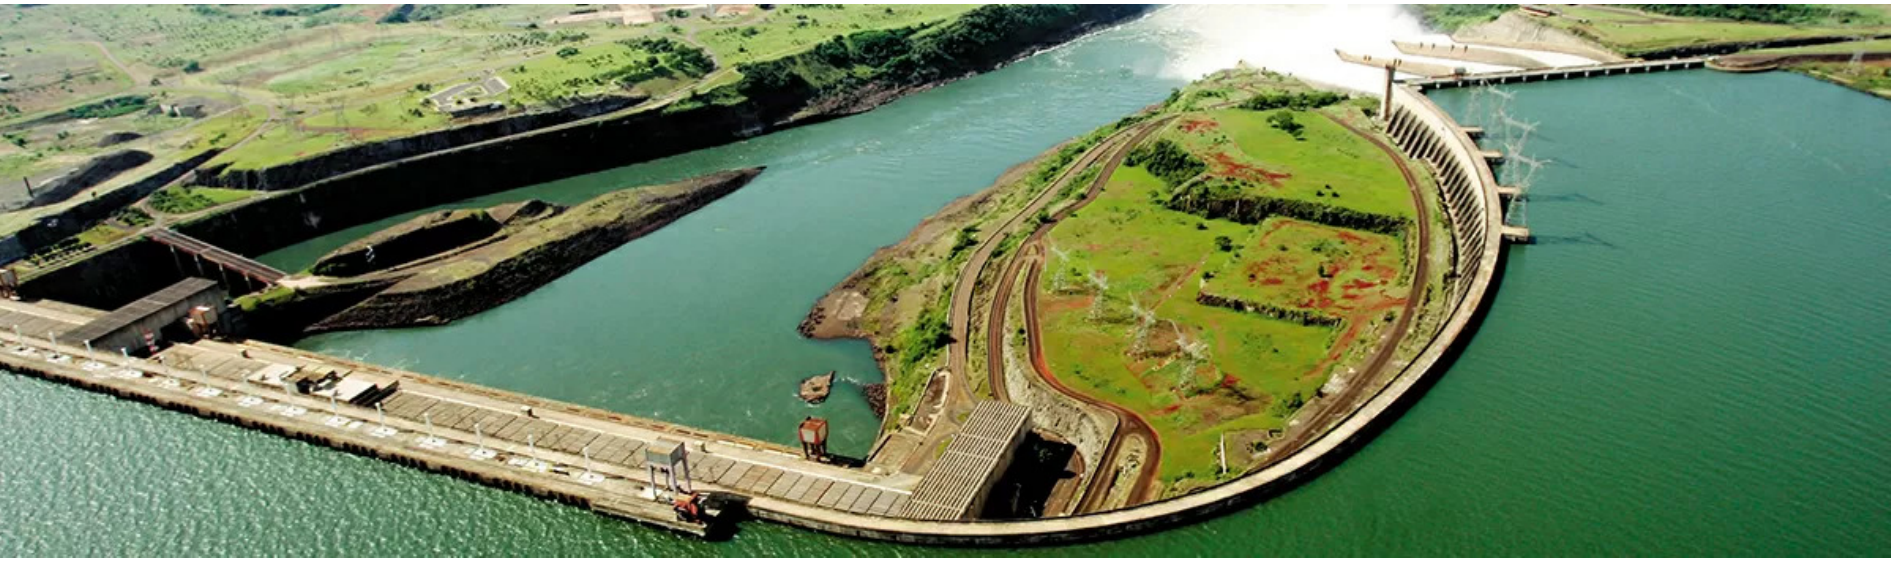
Figure 12. Large hydro-power installation capable of supplying electricity to a population of 30,000 persons. Credit: General Electric Corporation.